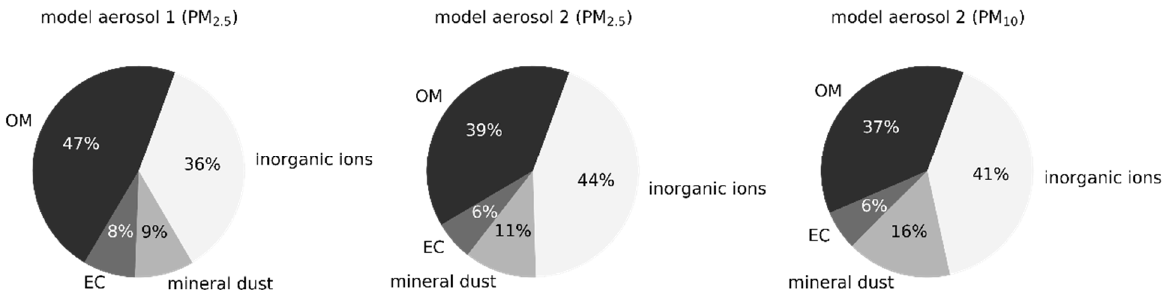
Figure 2. PM composition (%) of the two model aerosols.